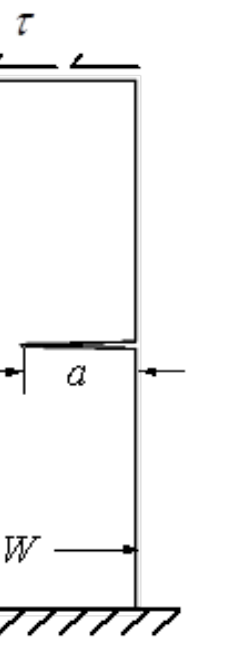
Figure 7. Problem statement for the single edge notched specimen under shear load.